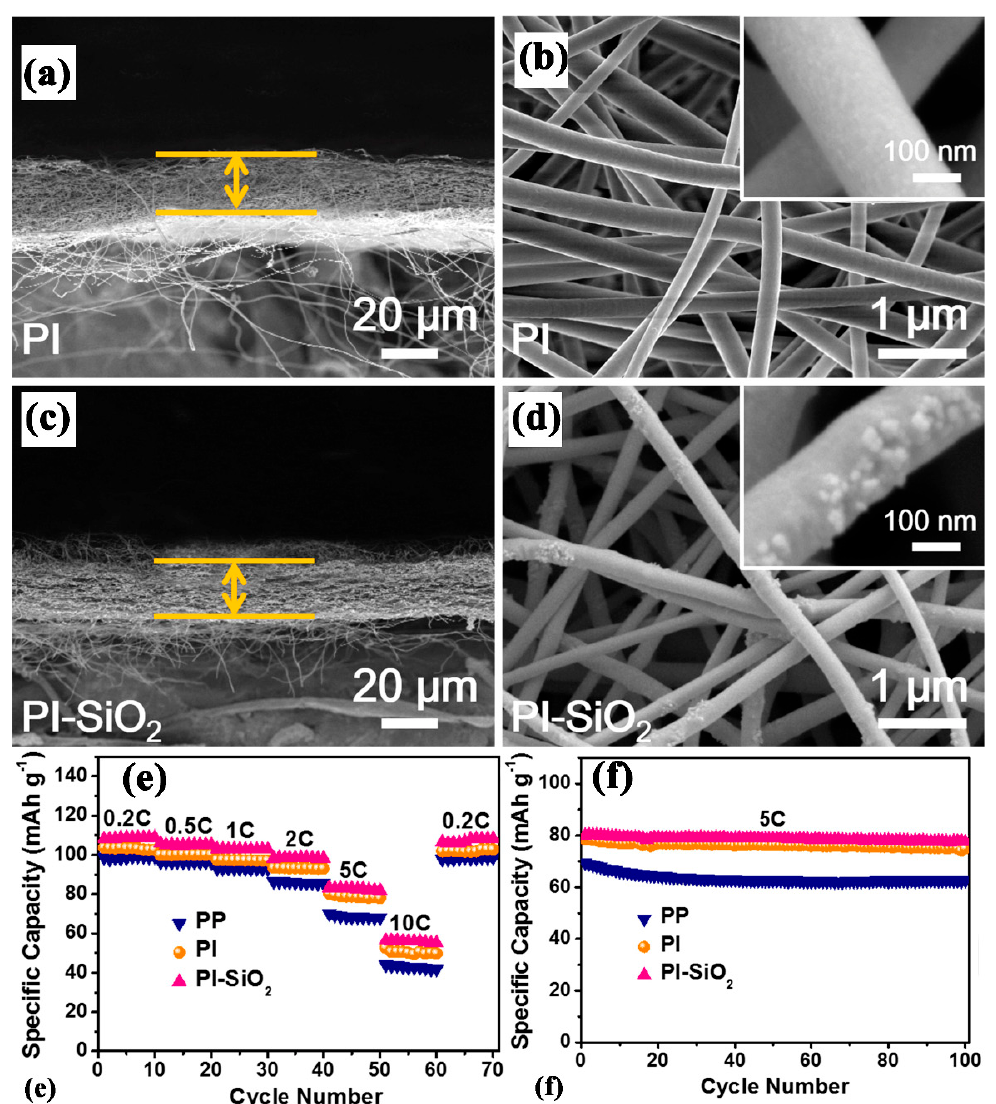
Figure 6. ( a ) Cross-sectional and ( b ) surface SEM image of PI (the inset is corresponding high- magnification image) ( c ) cross-sectional and ( d ) surface SEM image of PI-SiO 2 (the inset